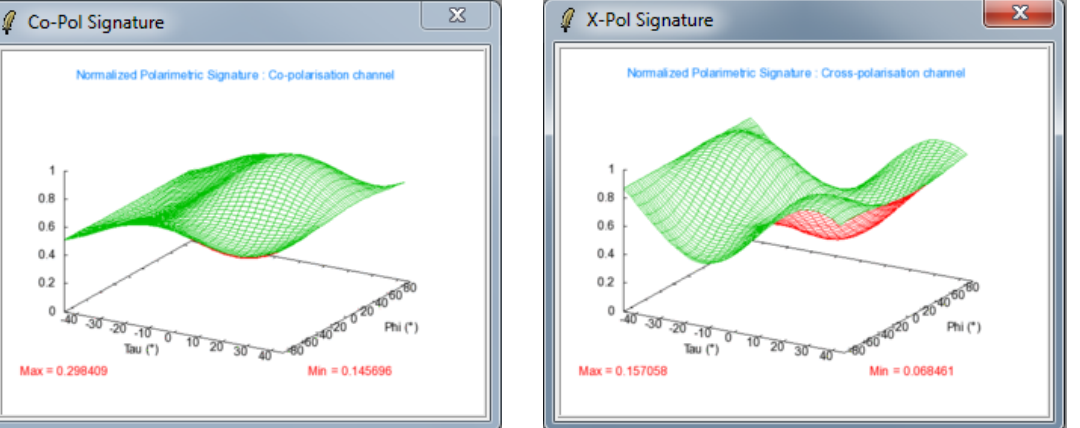
Figure 6. (b) Chlorite schist polarimetric signature